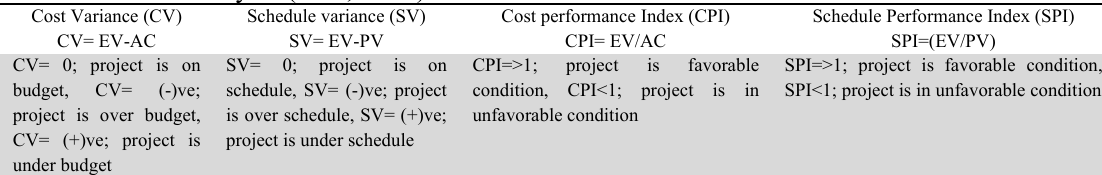
EVMS variance analysis (PMI,